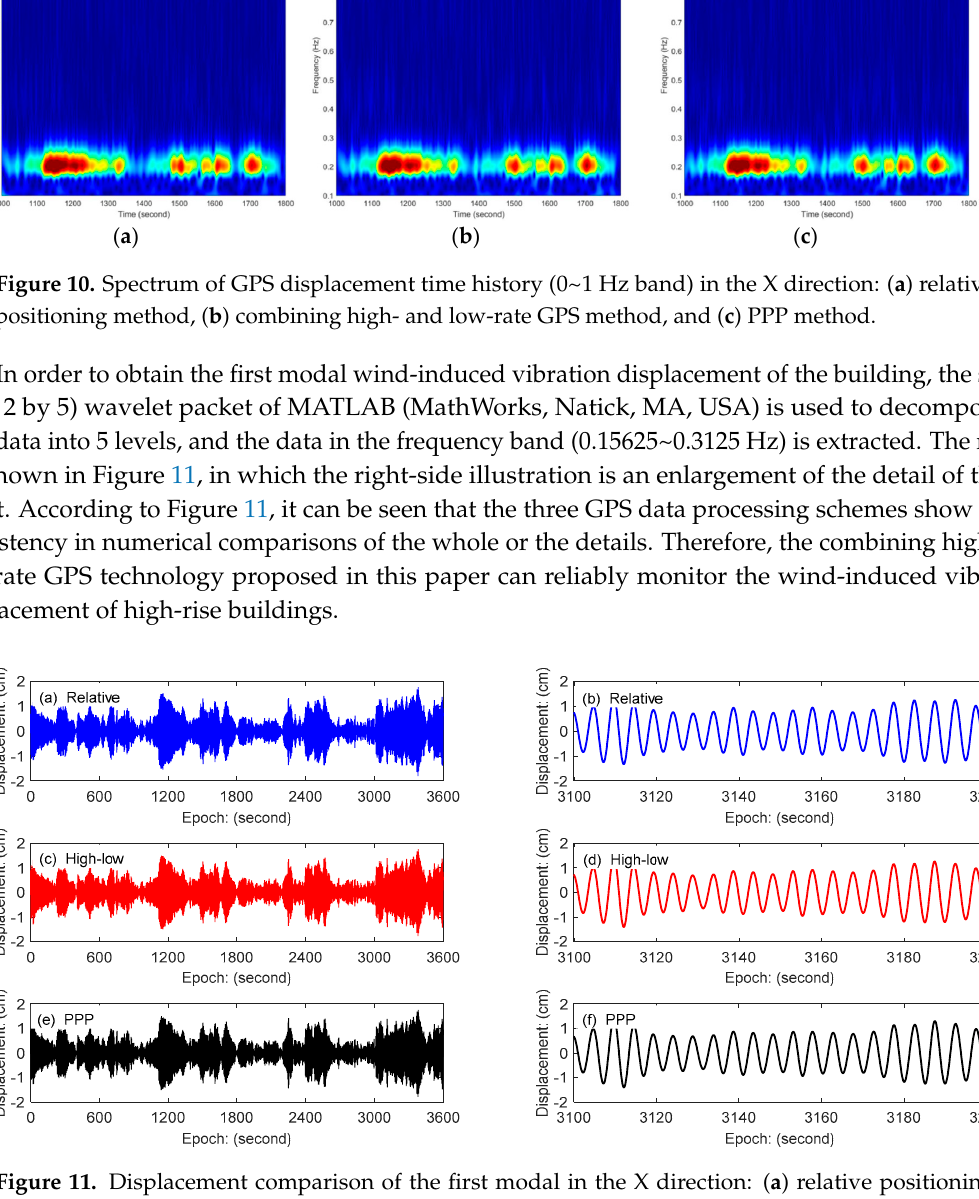
Figure 9. Spectrum analysis of GPS and accelerometer observation sequence: ( a ) X direction acceleration data; ( b ) Y direction acceleration data; ( c ) X direction relative positioning method; ( d ) Y direction relative positioning method; ( e ) X direction combining high- and low-rate GPS method; ( f ) Y direction combining high- and low-rate GPS method; ( g ) X direction PPP method; and ( h ) Y direction PPP method.